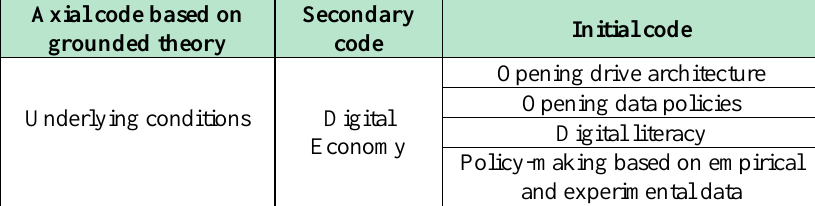
Table 4: Open coding of qualitative data (Underlying conditions) Axial code based